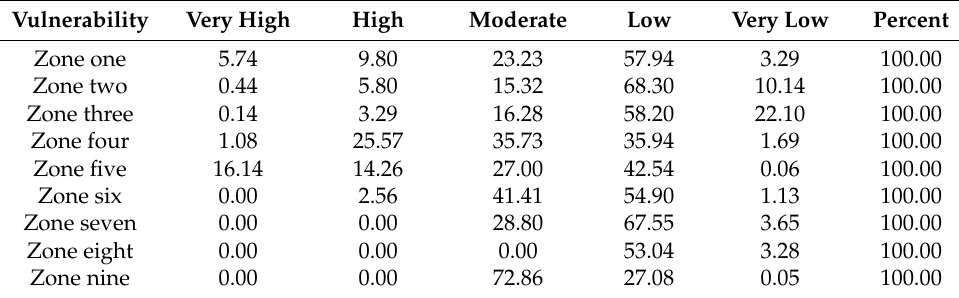
Table 8. Level of vulnerability of the Tabriz, Iran, municipality zones according to